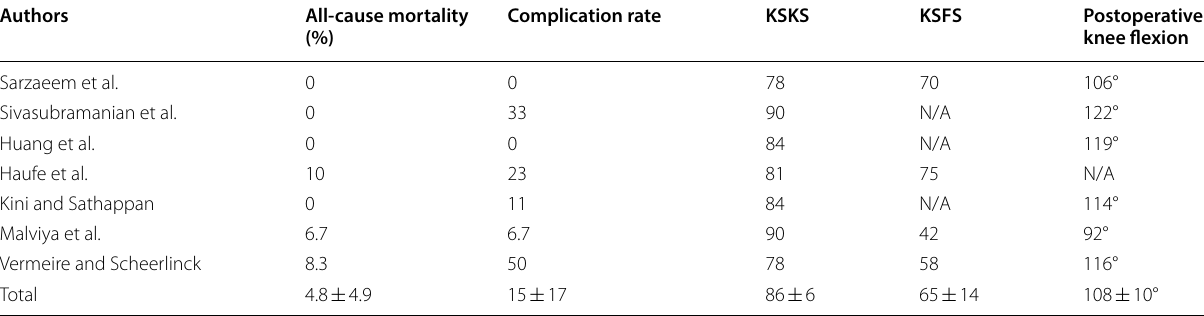
KSKS Knee Society Knee Score, KSFS Knee Society Function Score, N/A , not